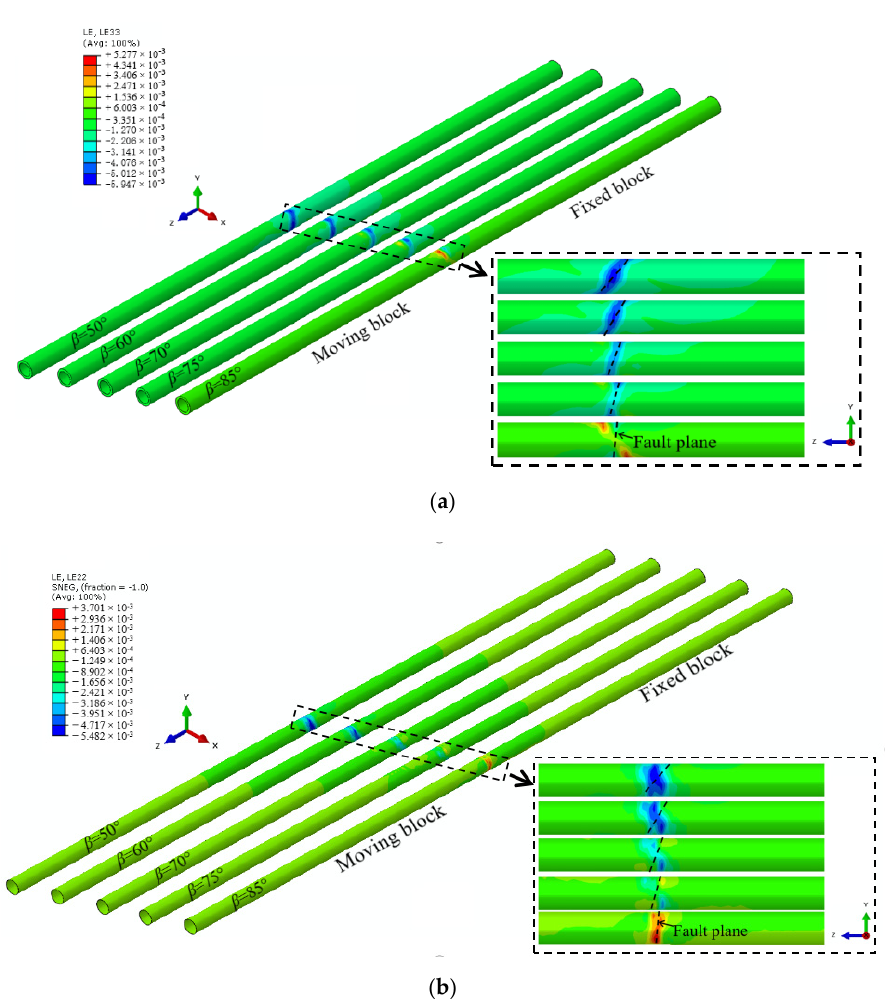
Figure 9. Axial strain nephogram at different dip angles of faults ( Δ f =8 cm and stiff): ( a ) Concrete lining and ( b ) steel tube lining.